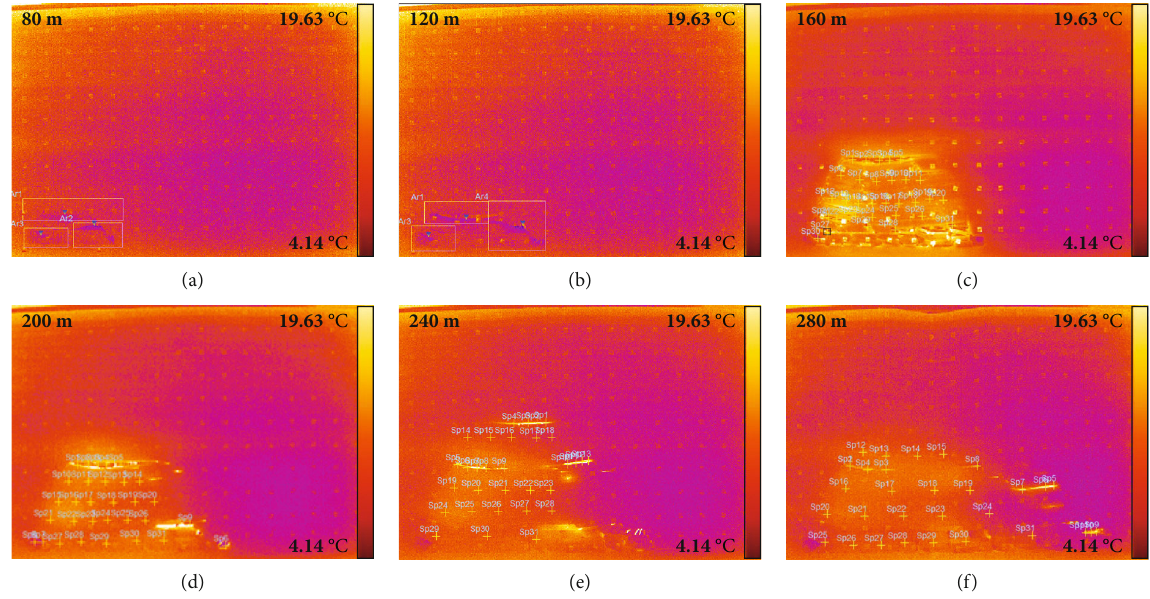
Figure 7: Evolution characteristics of overburden temperature fi eld during advancing of working face.